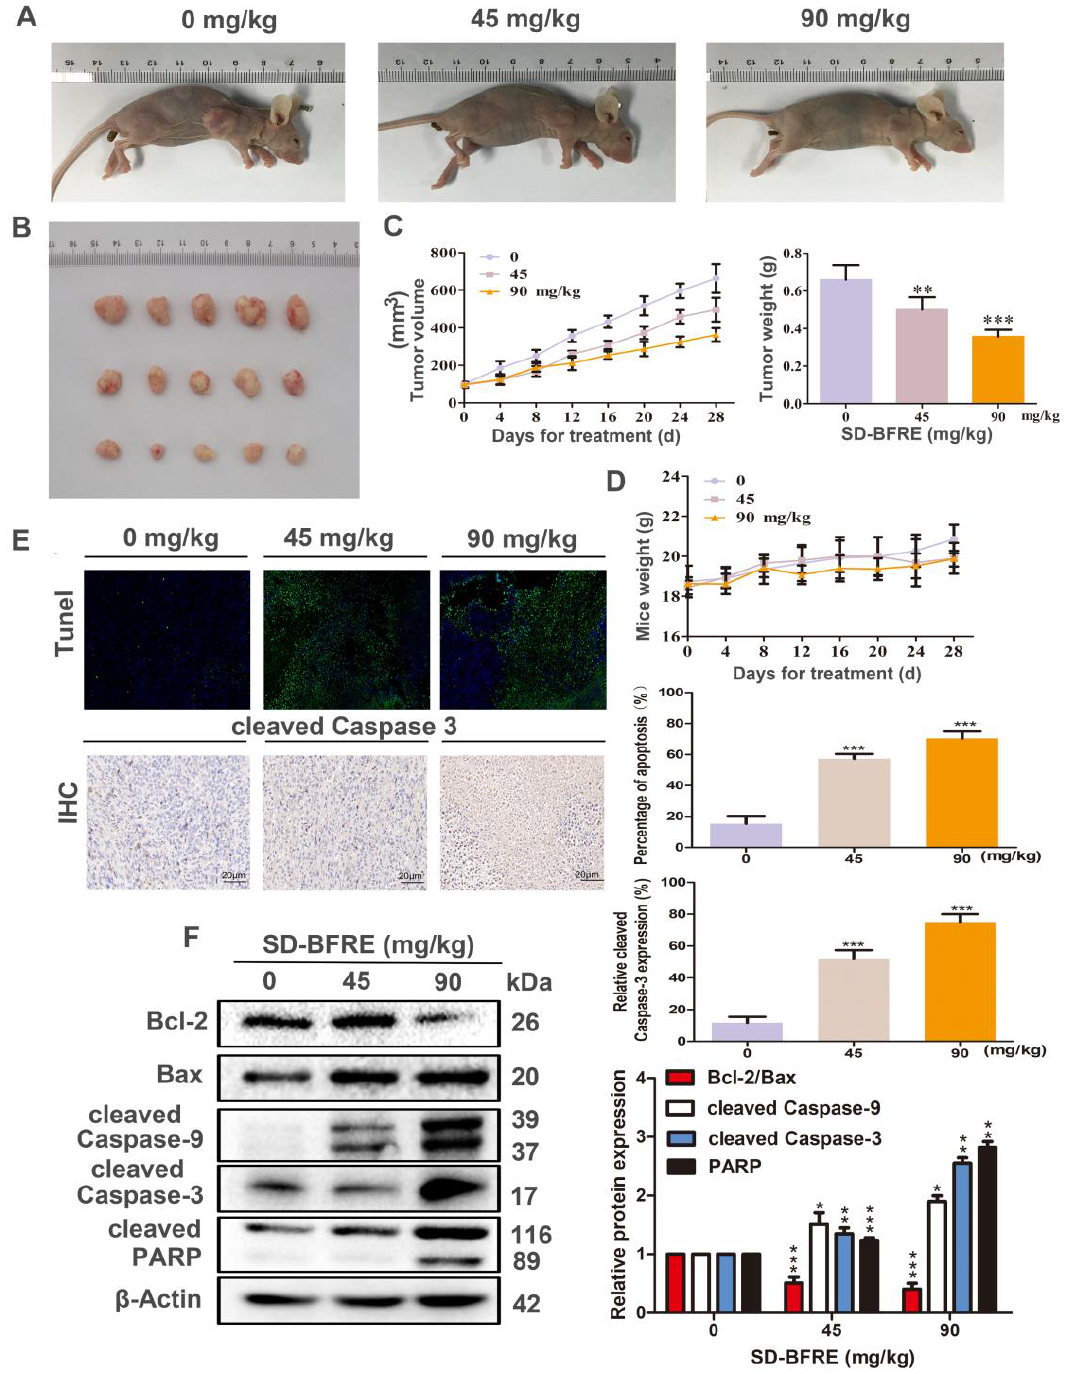
Figure 5. SD-BFRE inhibited Hep-2 xenograft growth and induced apoptosis in vivo. ( A , B ) The Hep-2-bearing mice were administrated with different dosage SD-BFRE for 28 days. The size of tumors in treated mice was measured when the experiment was over. ( C , D ) Every 4 days during the experiment, the mice were weighed with a balance, the volume of the tumors was measured with a vernier caliper and the tumors were dissected and weighted when the experiment was over. ( E ) Tumor sections of Hep-2 nude mice were subjected to TUNEL and IHC staining. ( F ) Proteins were extracted from SD-BFRE-treated tumor tissues, and the expressions levels of apoptosis-related proteins were detected by Western blot assay. β -actin was served as an internal reference (* p < 0.05, ** p < 0.01 or *** p < 0.001, compared to 0 mg/kg).